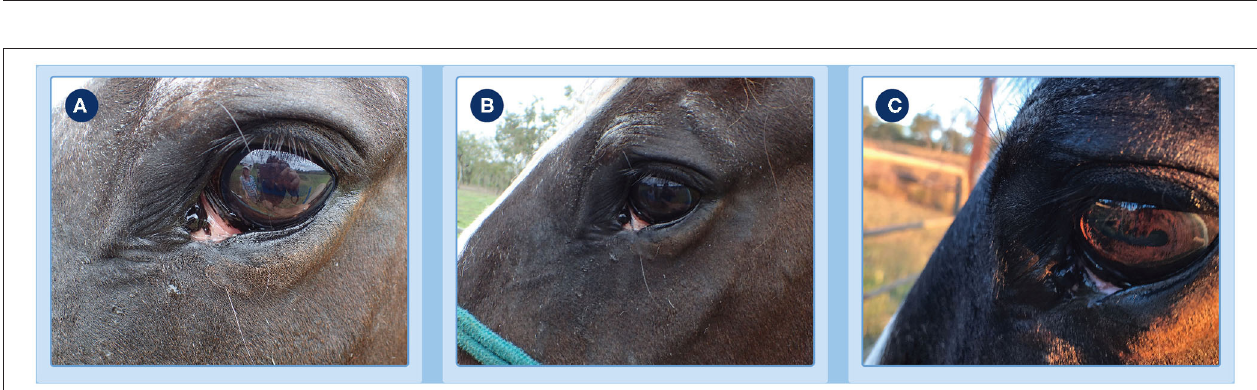
FIGURE 4 | Progression of clinical response of a peri-ocular SCC to treatment with tigilanol tiglate. Healed treatment site at day 73 (A,B) and day 189 (C) showing no recurrence of the tumor.